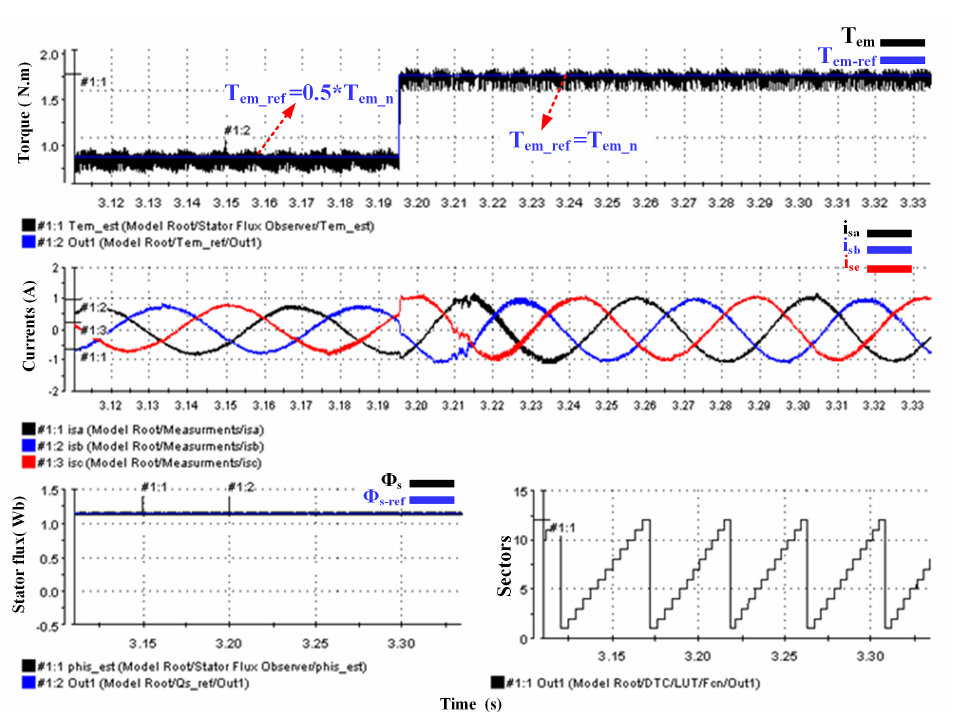
Figure 22. Experimental results of the improved twelve sectors based DTC